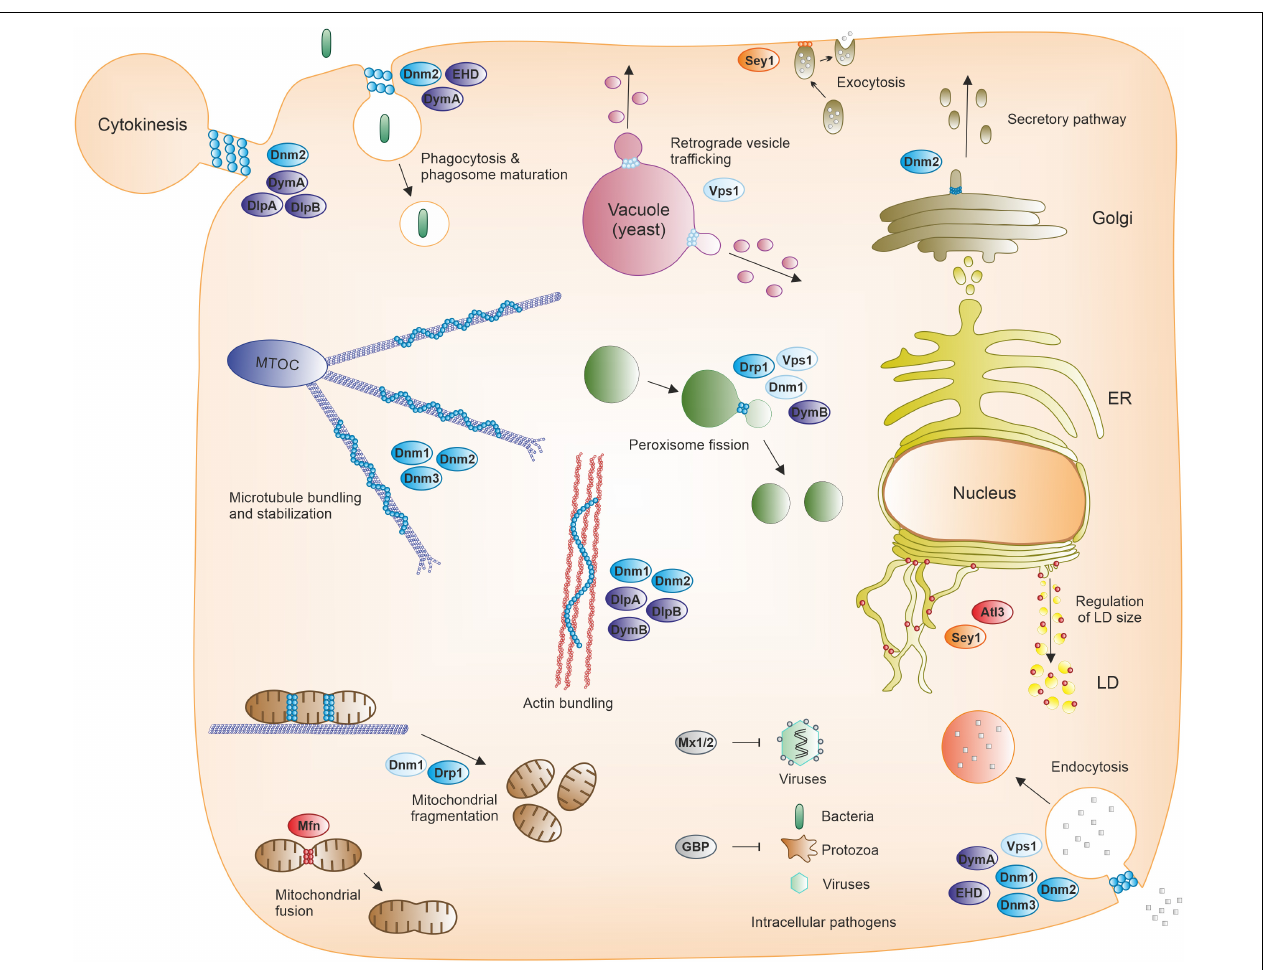
FIGURE 4 | Cellular processes mediated by dynamin superfamily proteins. Fission, fusion, and membrane-independent scaffold DSPs participate in various cellular processes, including endomembrane transport (such as phagocytosis, macropinocytosis, endocytosis, secretory and retrograde trafficking, or autophagy), organelle and cytoskeleton homeostasis, cytokinesis, and immunity against viral, bacterial and protozoan pathogens. ER, endoplasmic reticulum; GBP, guanylate-binding protein; LD, lipid droplet; MTOC, microtubule-organizing center; Mx1/2, Myxovirus resistance protein